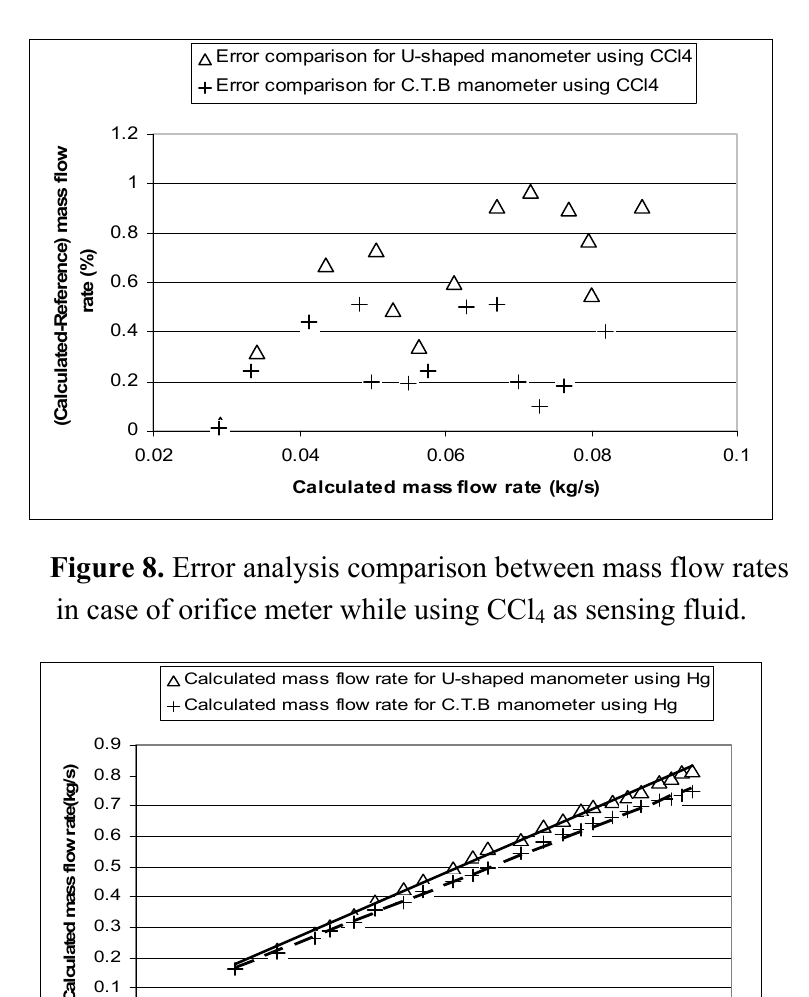
Figure 9 . Comparison between reference and calculated mass flow rates in case of venturimeter using Hg as manometer